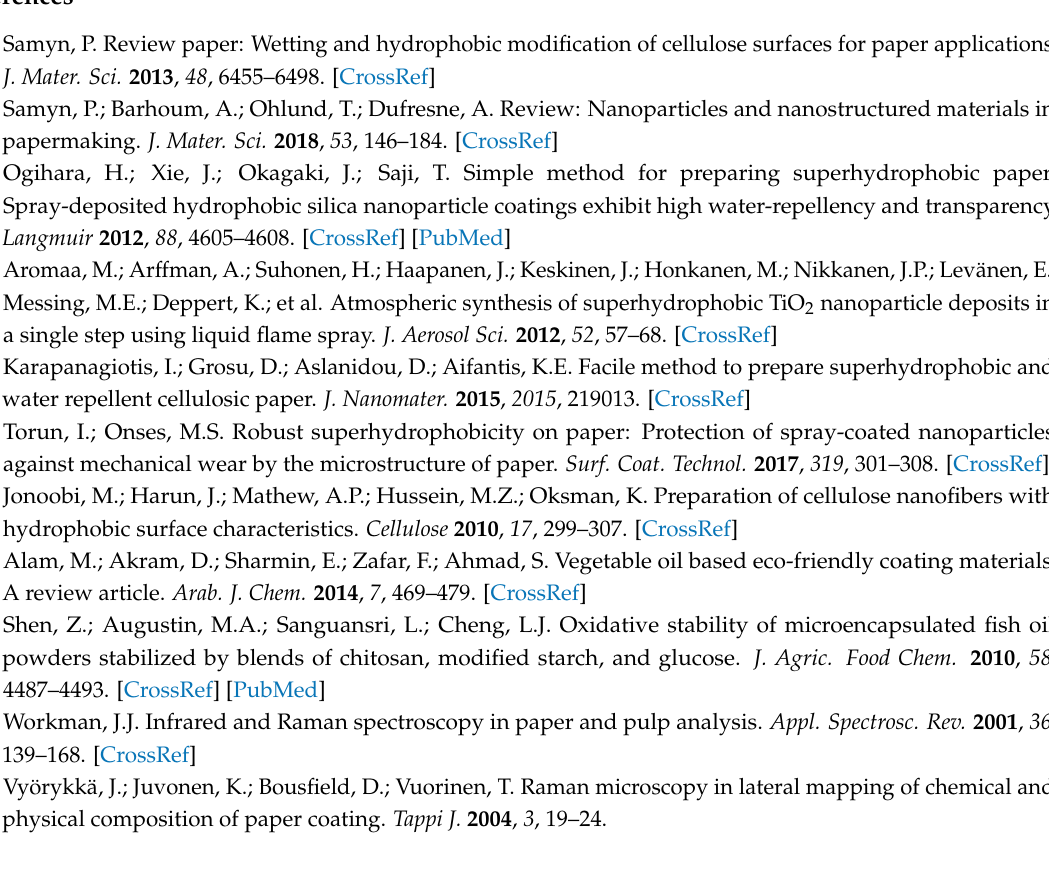
Figur S1: Reference SEM image of uncoated paper and the same magnifications of the coated paper samples; Figures S2–S5: Raman maps (5 × 5 mm 2 ) with single wavenumbers representing different coating and substrate components at the surface for SMI/oil paper coatings, Table S1: Raman shift assignment for SMI/oil coatings on